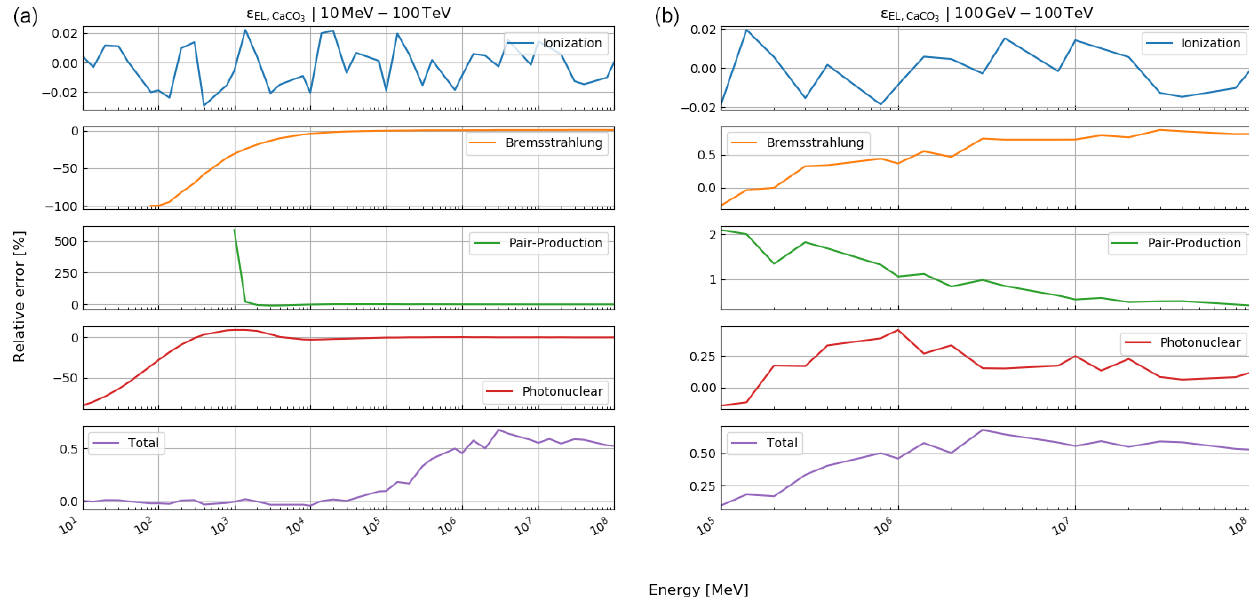
Figure E10. Relative error of our energy loss calculations compared to the tabulated values from Groom et al. (2001) for calcium carbonate (calcite) in the energy ranges (a) 10MeV–100TeV and (b) 100GeV–100TeV.